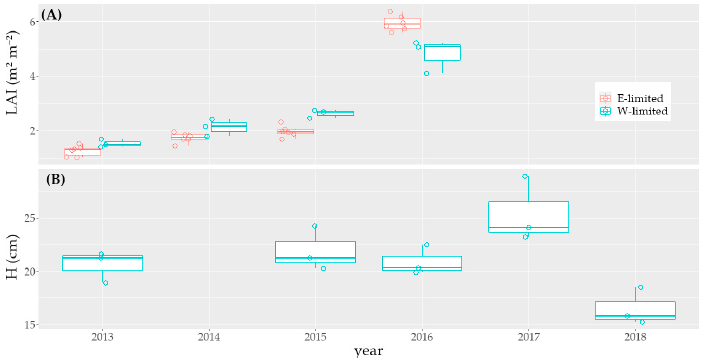
Figure A2. Mean annual grass height (H) for Rollesbroich, the energy-limited site (E-limited, blue) and Selhausen, water-limited site (W-limited,